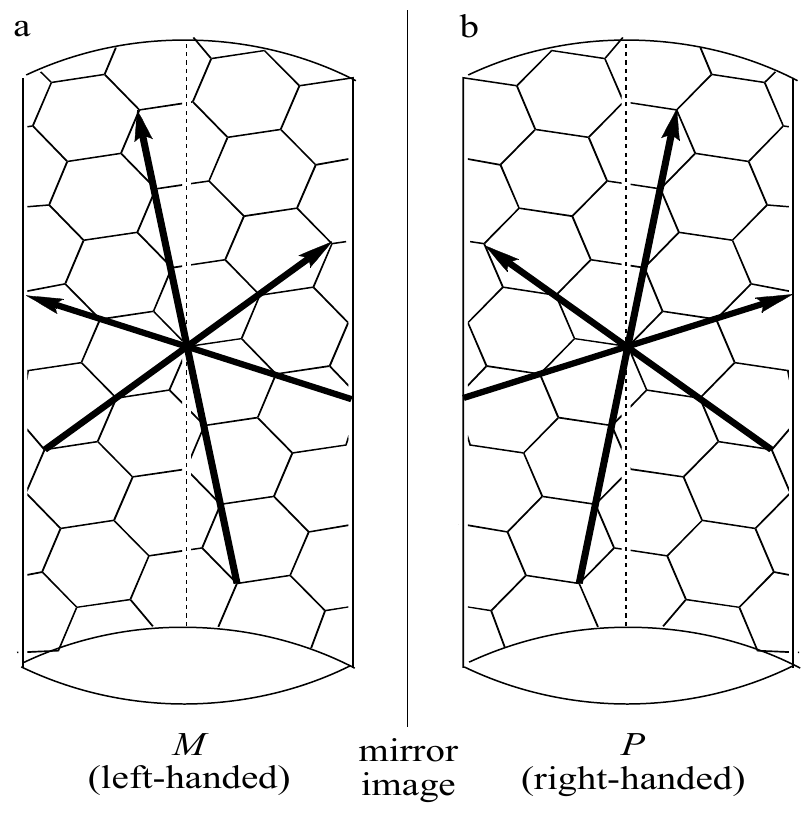
Figure 3. Definition of (a) M (left-handed) and (b) P (right-handed) chiral SWNTs. Three arrows and dashed line indicate zigzag lines and SWNT axis,